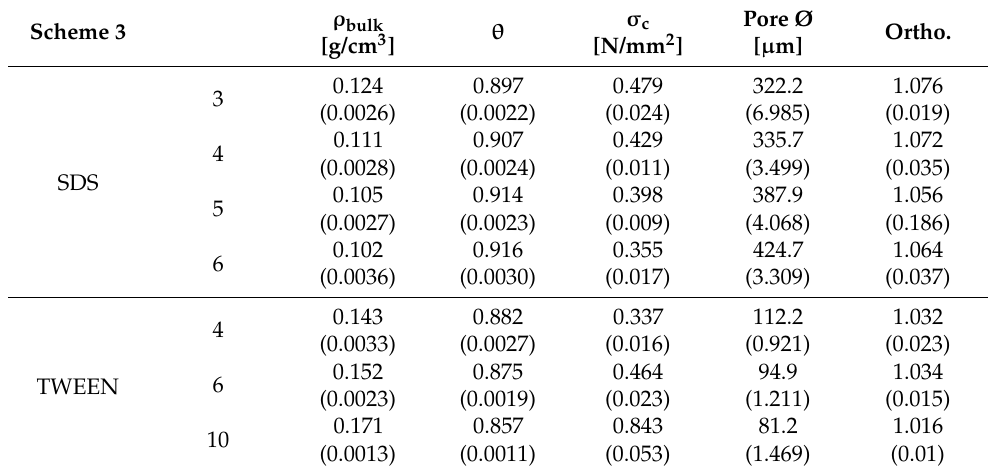
Table 1. Results for mechanically beaten foams. Mean values and standard deviation in